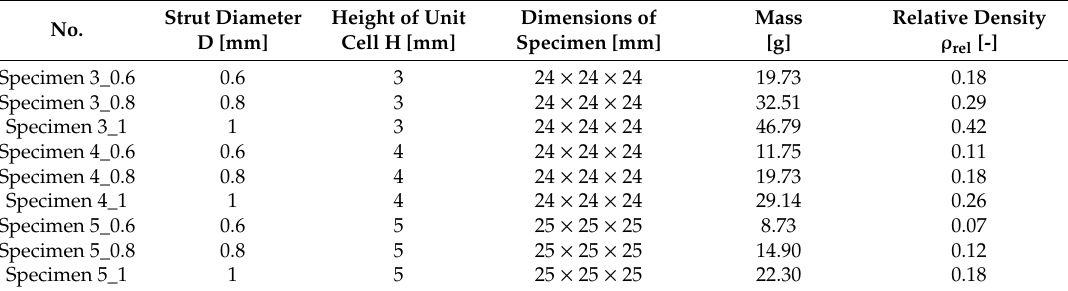
Figure 2. Geometrical assumptions undertook during the specimen manufacturing process. Table 1. Geometrical specifications of the developed lattice structures.